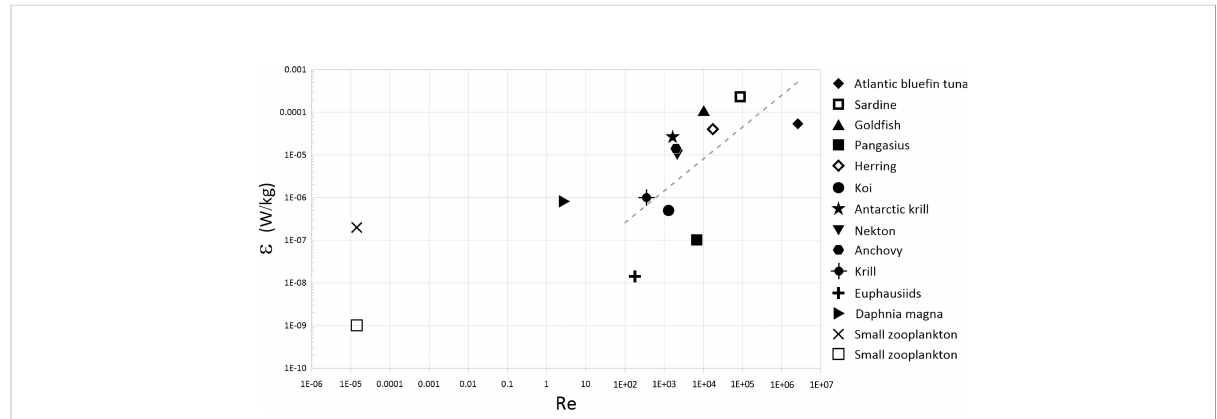
FIGURE 12 Dissipation rates associated with aquatic species having different Reynolds numbers based on the cruise speed. The broken line is a least- squares linear regression fi tted to the data with Re >